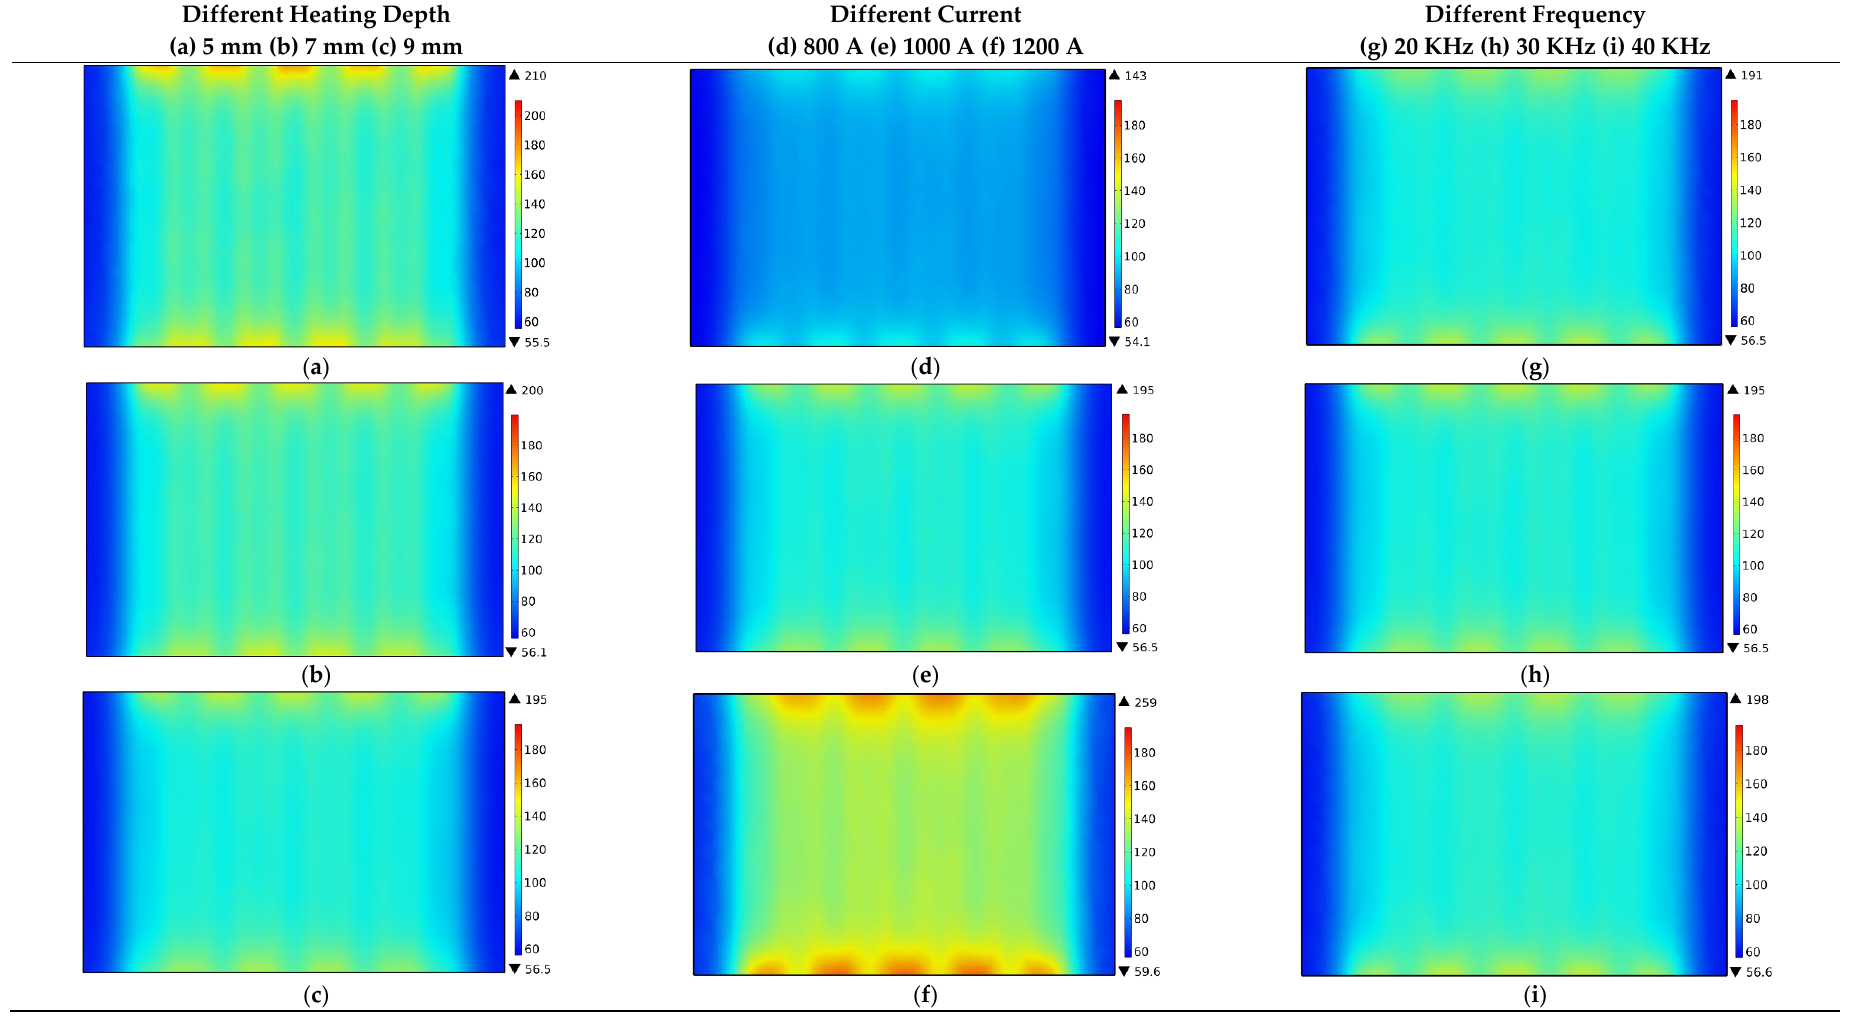
Figure 3. Temperature distribution nephograms on the mold surface under different parameters.